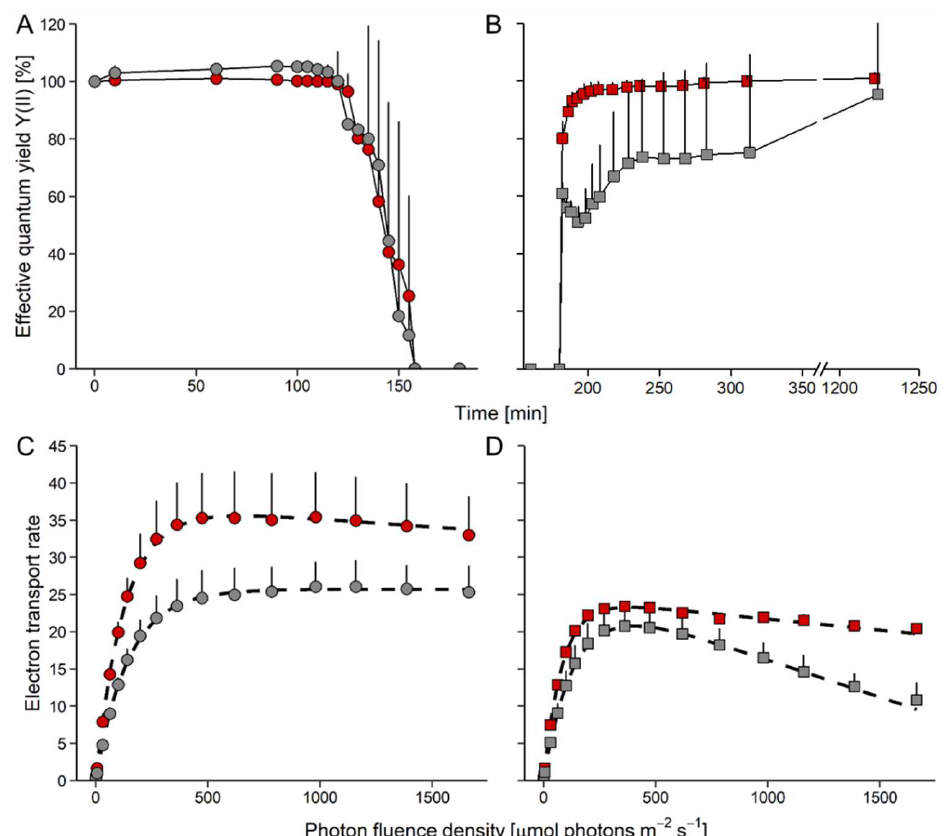
Figure 3. Effects of desiccation and rehydration on photosynthesis in Edaphochlorella mirabilis and Diplosphaera epiphytica . Red symbols denote D. epiphytica and grey symbols show E. mirabilis . ( A ) Effective quantum yield during desiccation under 84% relative humidity and ( B ) during the subsequent rehydration under 95% relative humidity; data are means ± SD ( n = 5) expressed as a percentage of the initial values at time 0. ( C ) Electron transport rates of algae before desiccation and ( D ) after the end of rehydration; data are means ± SD ( n = 4). Two-way ANOVA ( p < 0.05) showed that the two species in panels ( B – D ) differed significantly.